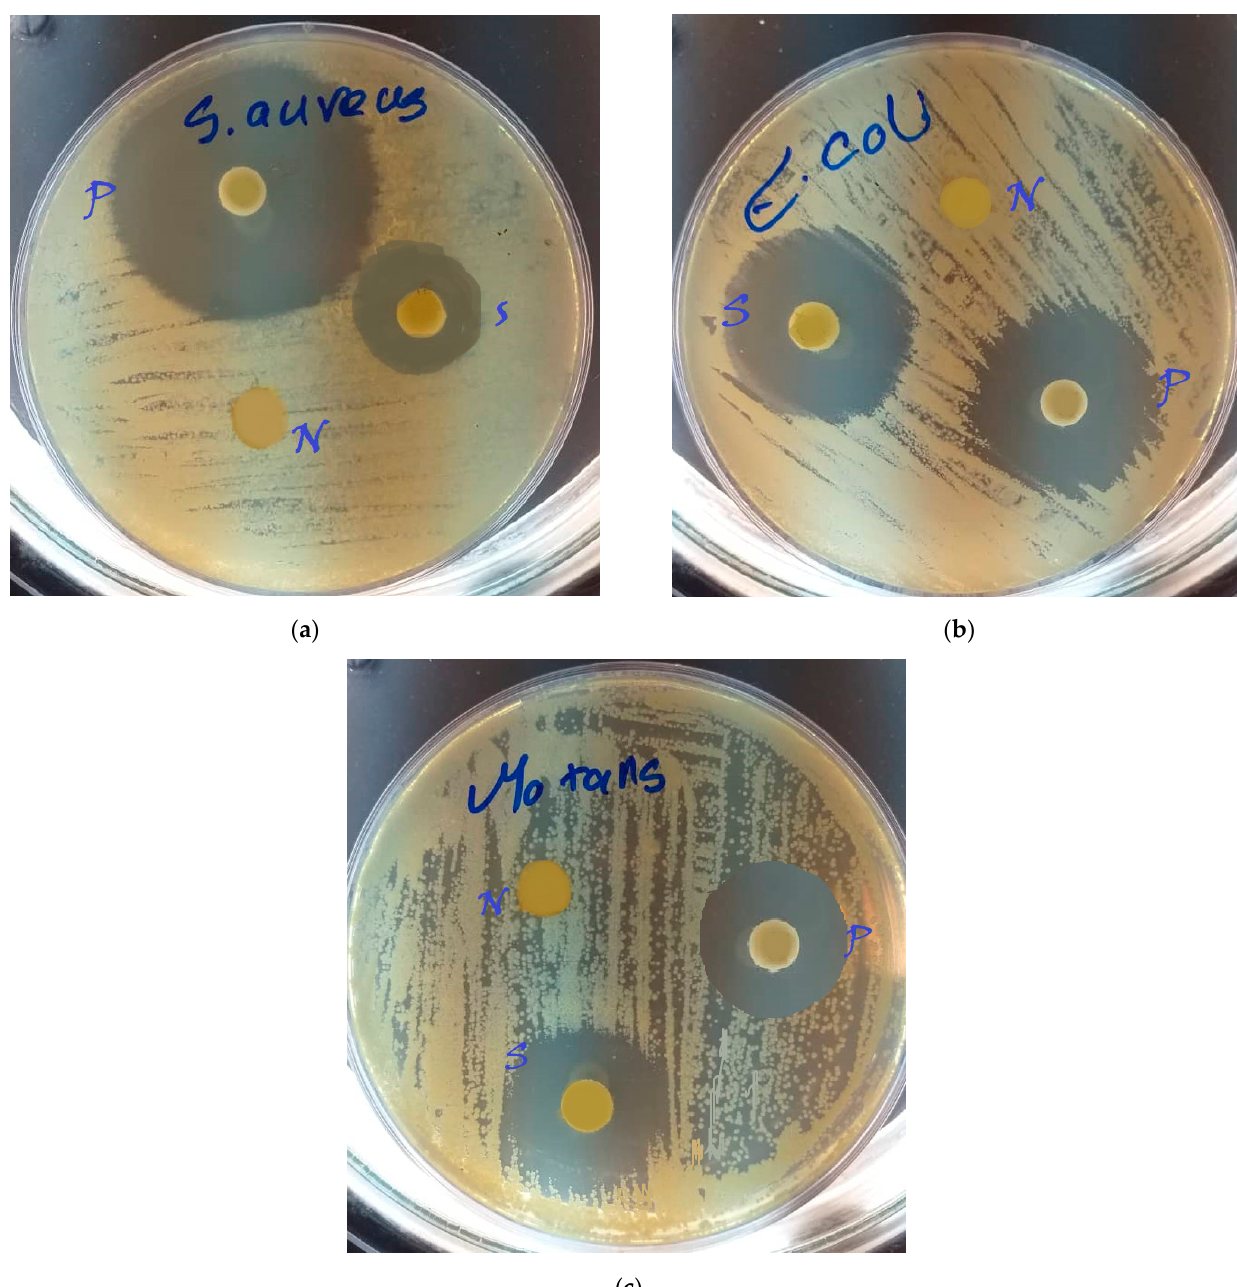
Figure 6. Findings of the antimicrobial assessment for three types of bacteria; ( a ) Staphylococcus aureus , ( b ) Escherichia coli and ( c ) Streptococcus mutans .